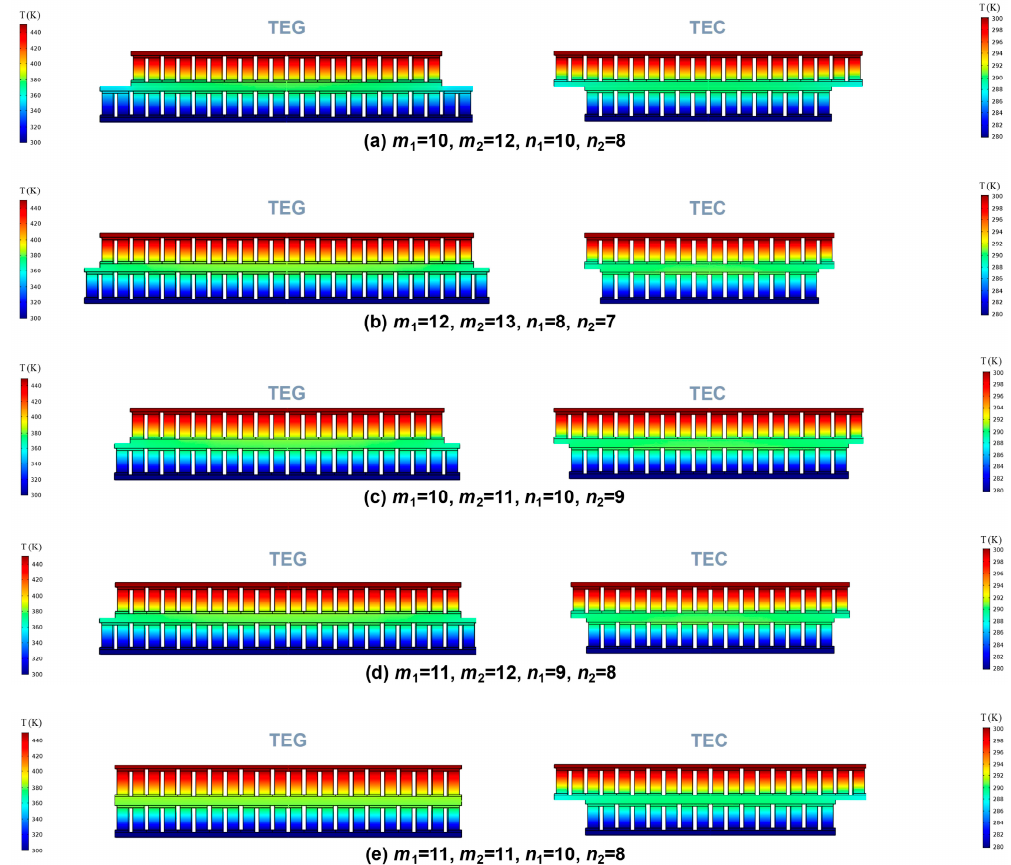
Figure A2. Temperature profiles of five different allocation design with: ( a ) m 1 = 10, m 2 = 12, n 1 = 10, n 2 = 8; ( b ) m 1 = 12, m 2 = 13, n 1 = 8, n 2 = 7; ( c ) m 1 = 10, m 2 = 11, n 1 = 10, n 2 = 9; ( d ) m 1 = 11, m 2 = 12, n 1 = 9, n 2 = 8; and ( e ) m 1 = 11, m 2 = 11, n 1 = 10, n 2 = 8.